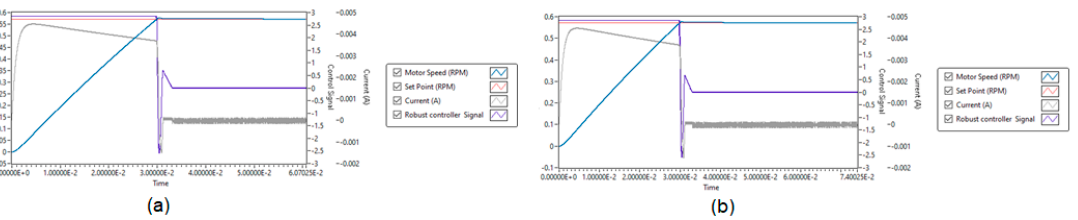
Figure 5. Robust controller ( a ) and conventional PID controller, ( b ) dynamic response when reference speed is 0.57 P.U. time in seconds.